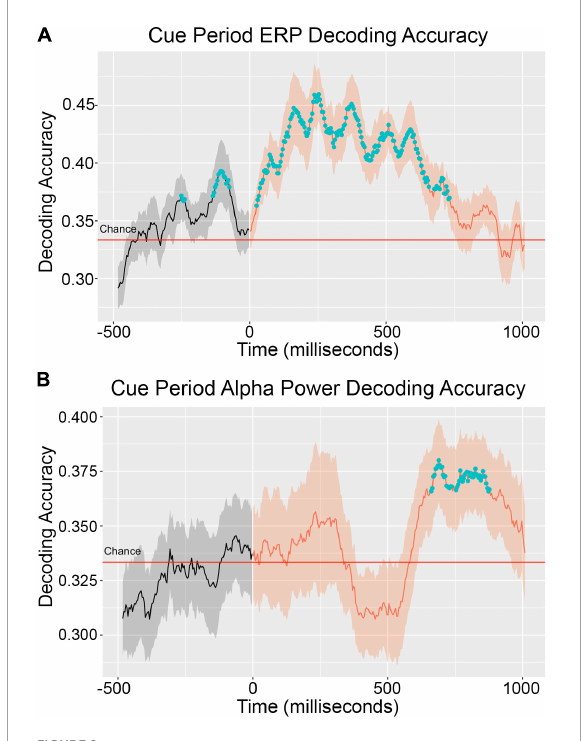
FIGURE2 Cue period decoding accuracy timeseries for ERP (A) and alpha power (B) . Decoding accuracy was averaged across EEG data from 20 participants. The solid line inside the shaded regions represents mean decoding accuracy across participants and the shading represents the standard error across participants. The blue dots denote clusters of time points statistically significantly greater than chance (33%). The ERP signal was extracted from the original EEG signal by low pass filter with a 6 Hz cutoff. Instantaneous alpha power was calculated with a Hilbert transform over 8–12 Hz bandpass filtered EEG